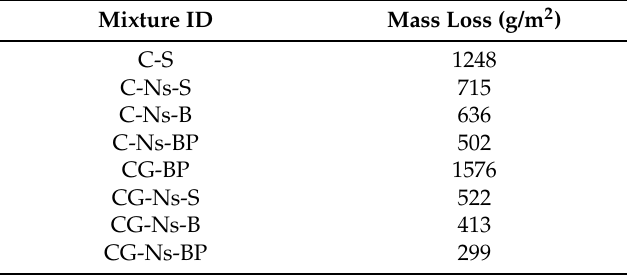
Table 7. The mass loss results after 28 freezing-thawing